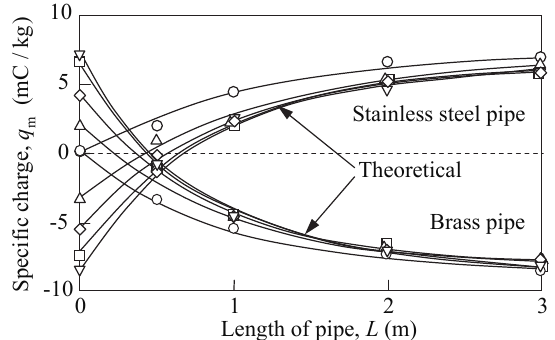
Fig. 1 Effect of initial charge and pipe material on par- ticle charging (alumina particles, count median diameter: 3.3 μ m, pipe diameter: 6 mm, air ve- locity: 40 m/s, mass flow ratio: 5 × 10 − 4 kg-par- ticle/kg-air).